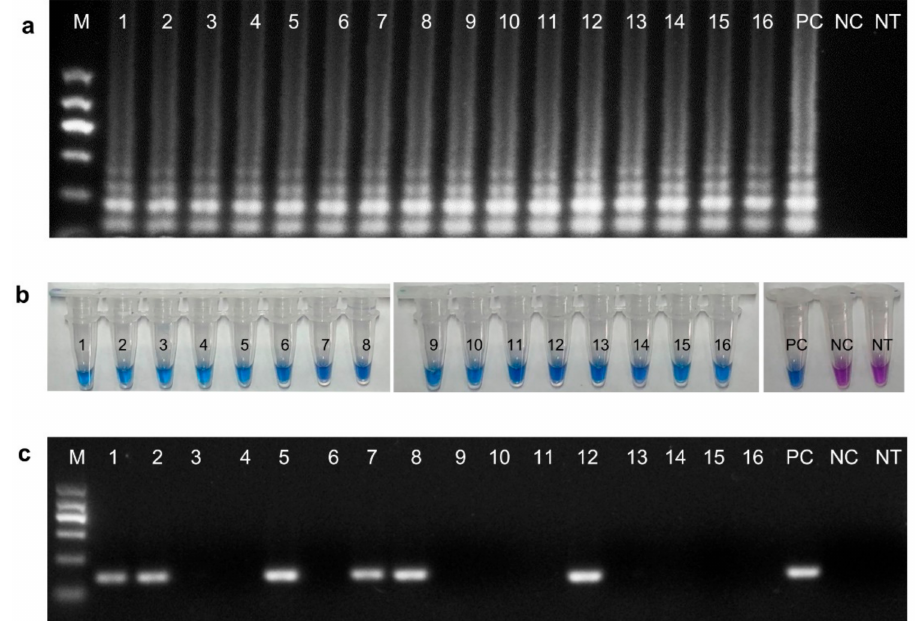
Figure 6. Detection of poplar black spot pathogen in the field samples by the LAMP and PCR assays. ( a ) LAMP assay products visualized by agarose gel electrophoresis. ( b ) LAMP assay products visualization by hydroxynaphthol blue (HNB). ( c ) PCR assay. PC = positive control (purified gDNA of M. brunnea strain XY-3); NC = negative control (purified gDNA from M. brunnea -free poplar leaves); NT = no DNA template. Lanes and tubes 1–16 are purified gDNA extracted from 16 leaves exhibiting classical black spot symptoms; M = molecular size